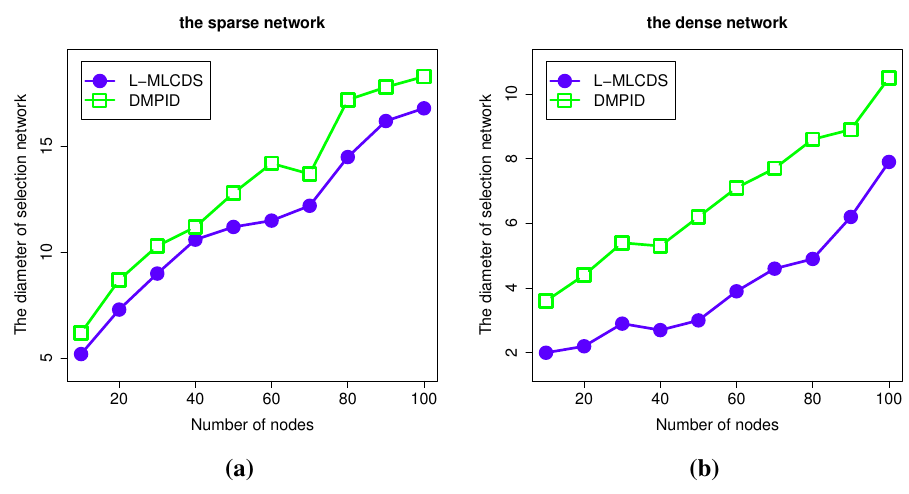
Figure 7. Simulation results for diameter of selection. The diameter of the selection in ( a ) the sparese network; ( b ) the dense